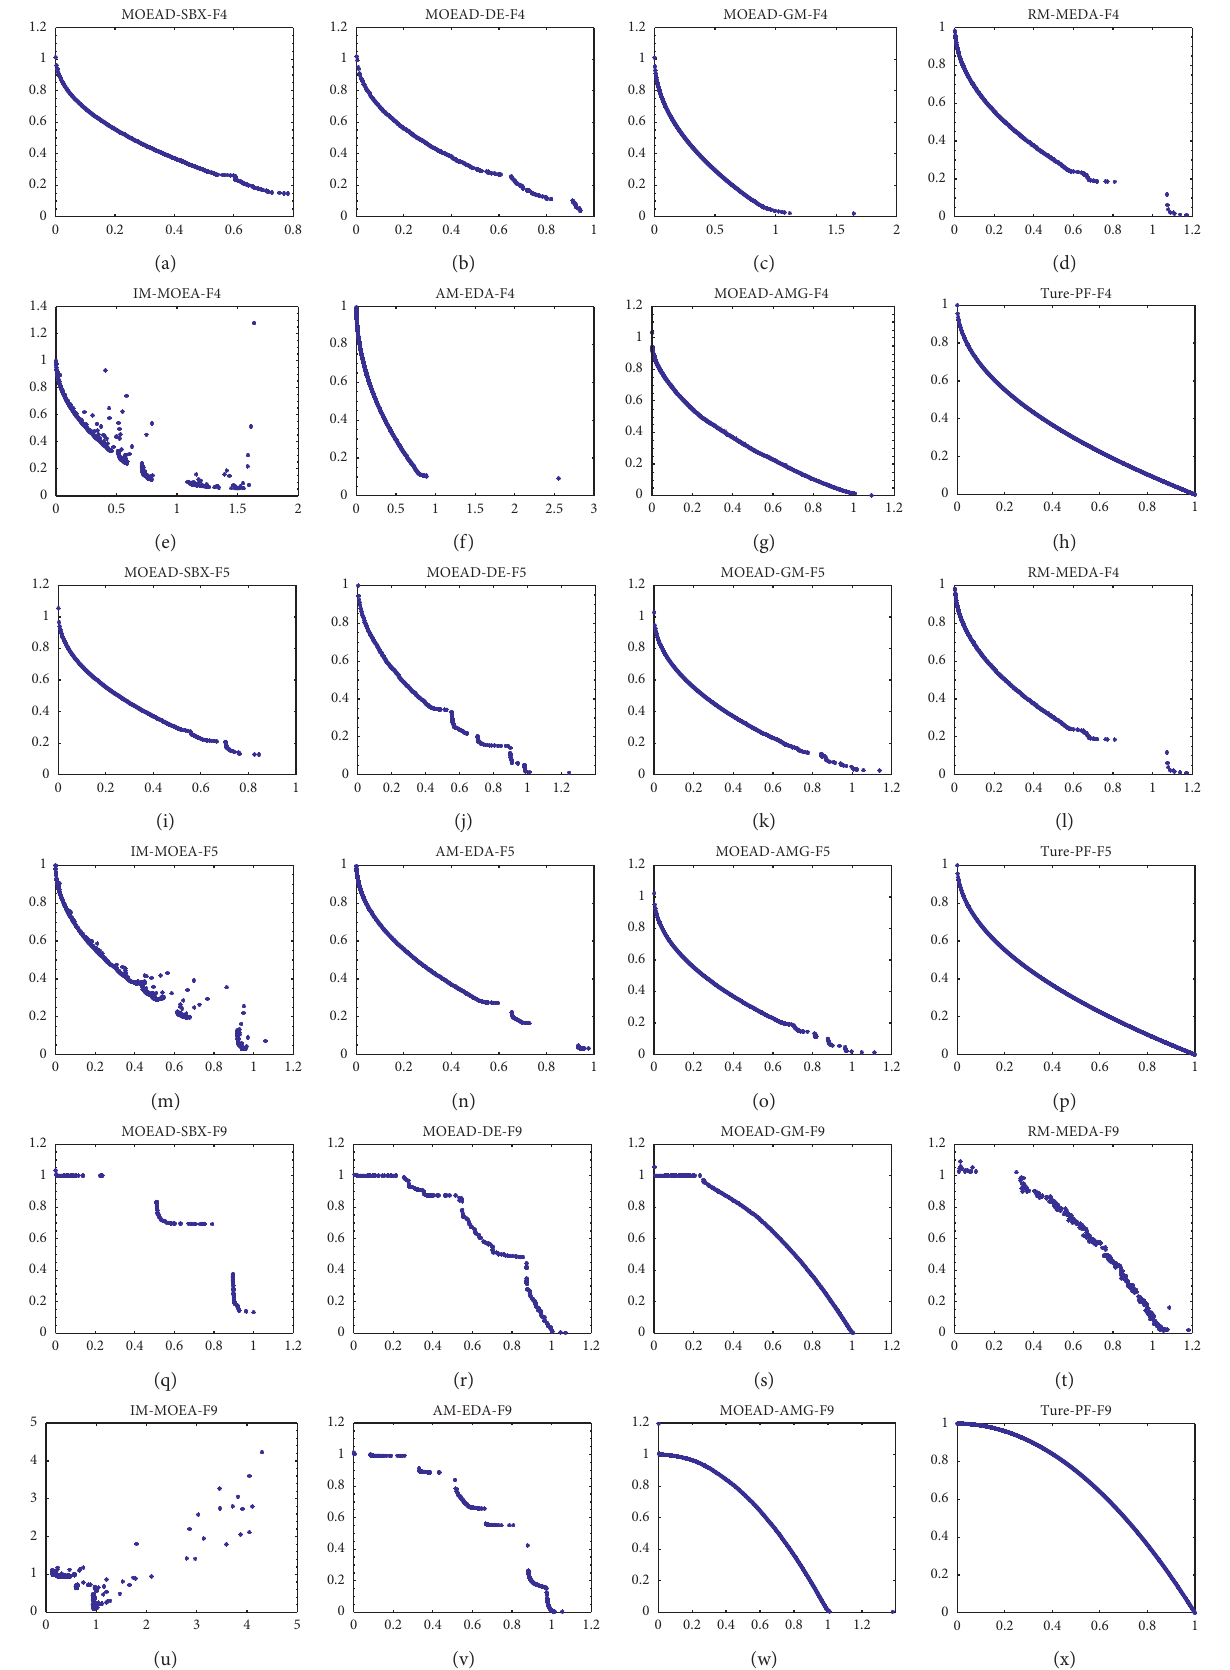
Figure 5: The final populations obtained by all the compared algorithms on F4, F5, and